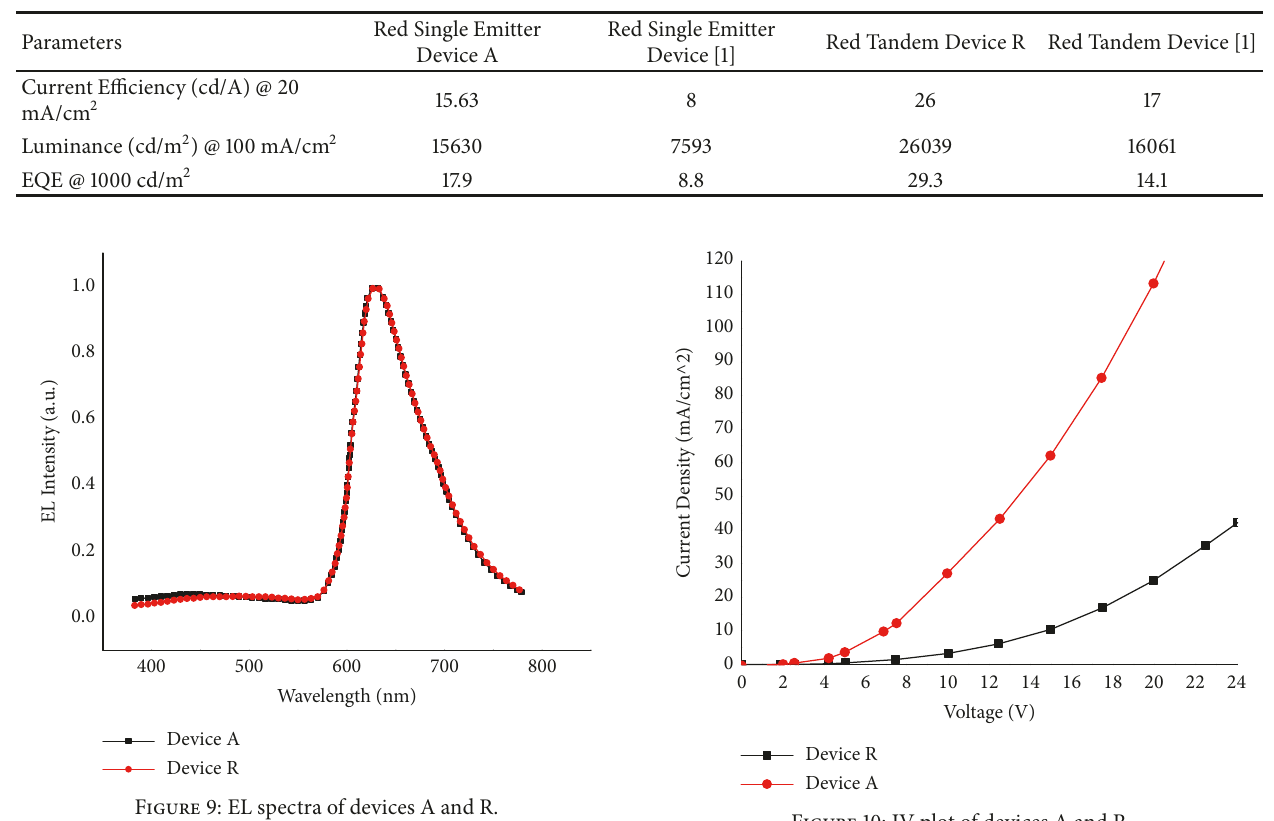
Table 4: Comparison of proposed devices with the corresponding devices used in [1].